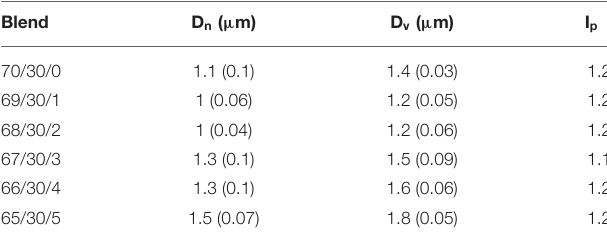
TABLE 2 | Number-average and volume-average PA12 droplet diameters (D n and D v ), PA droplet size polydispersity (I p ) with standard deviation in brackets of PLA/PA12/PLA-g-MA blends (compression molded samples).